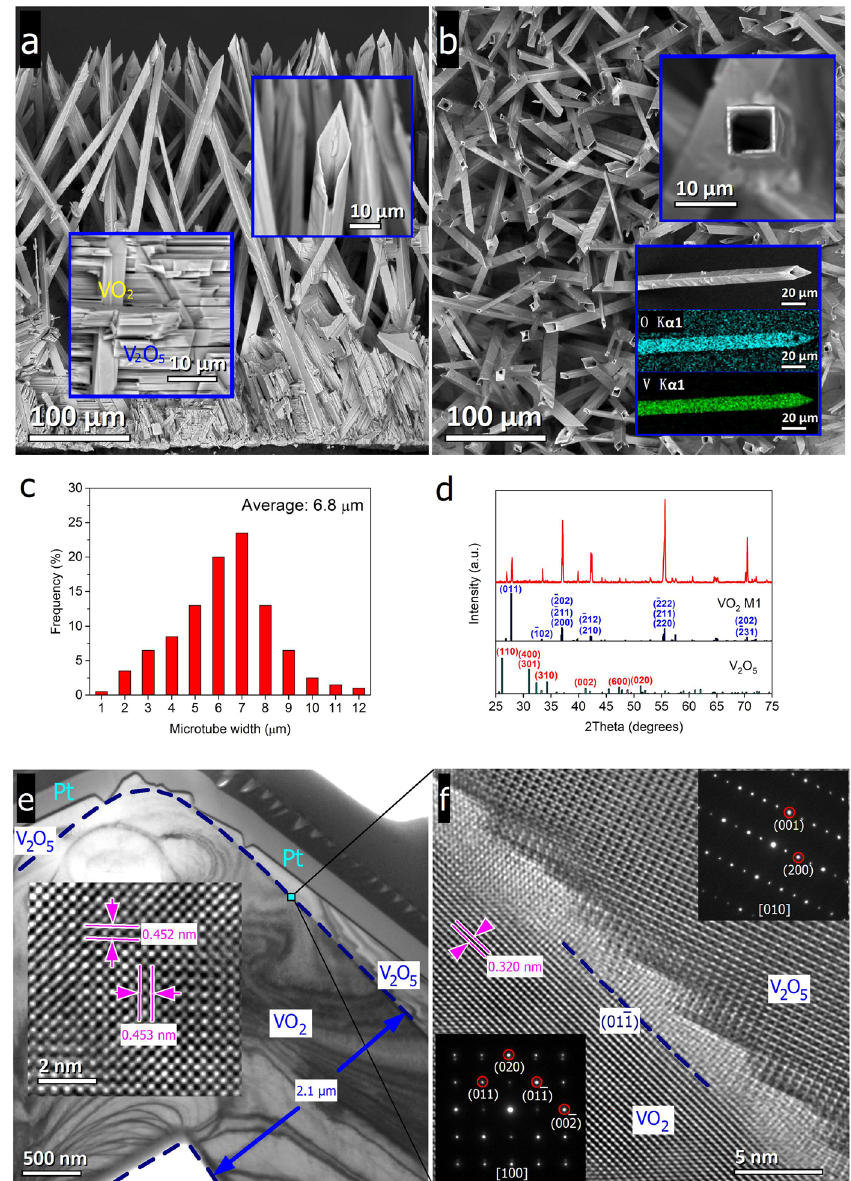
Fig. 2 Characteristics of single crystal VO 2 microtube arrays. a SEM image of the side view with the upper-right inset showing the top of a VO 2 microtube and the lower-left inset showing the bottom of a VO 2 microtube embedded in a layered V 2 O 5 substrate. b SEM image of the top view with the upper-right inset showing the rectangular cross-section of a VO 2 microtube and the lower-right inset showing an individual VO 2 microtube with a uniform width and its EDS maps. c Histograms of the VO 2 microtube widths tabulated from the SEM images in ( a ) and ( b ). d XRD pattern at room temperature with standard powder diffraction patterns of the M1 phase of VO 2 and V 2 O 5 . e TEM image of a VO 2 microtube with the inset showing its HRTEM image. A Pt layer was added to protect the sample surface from contamination during TEM sample preparation. f HRTEM image of the boundary between the VO 2 and the V 2 O 5 with the insets showing the electron diffraction images of the corresponding